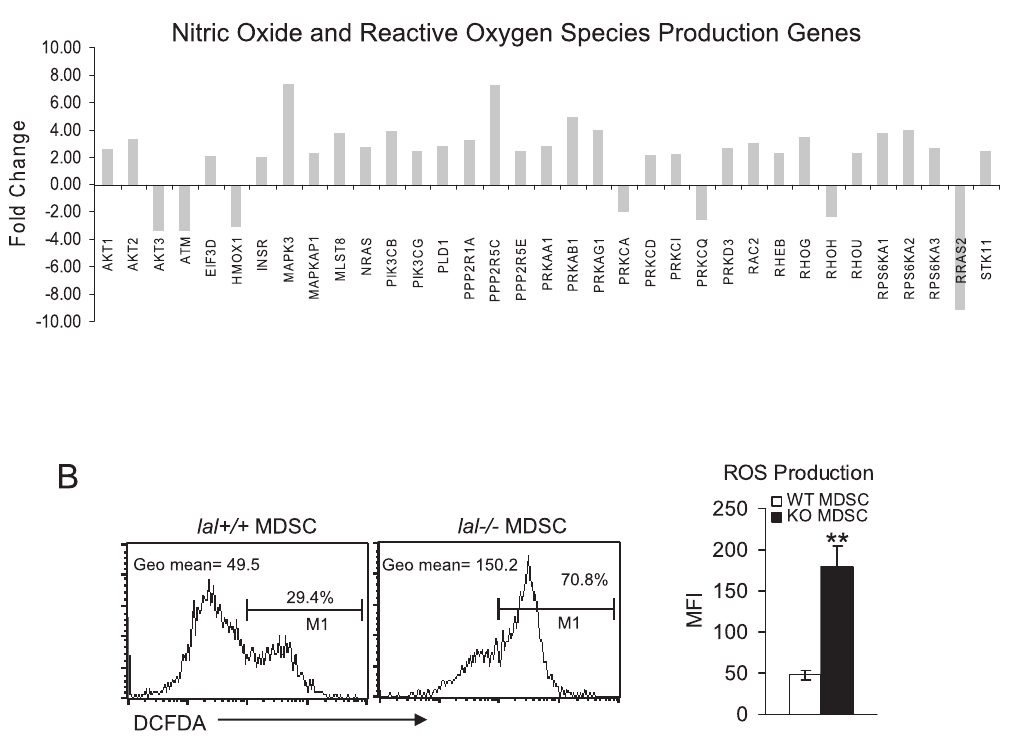
Figure 2. ROS Pathway Analysis of lal 2 / 2 bone marrow MDSCs. A ). Differential gene expression of CD11b + Ly6G + MDSCs from the bone marrow of lal + / + mice and lal 2 / 2 mice was analyzed by Ingenuity Pathway Analysis. Changed genes in the nitric oxide and reactive oxygen species production genes are presented; B ). ROS production in CD11b + Ly6G + MDSCs from the bone marrow of lal + / + mice and lal 2 / 2 mice. The ROS signal was statistically analyzed by mean fluorescent intensity (MFI). Results are means of 4 independent FACS experiments. n=4, **, p ,